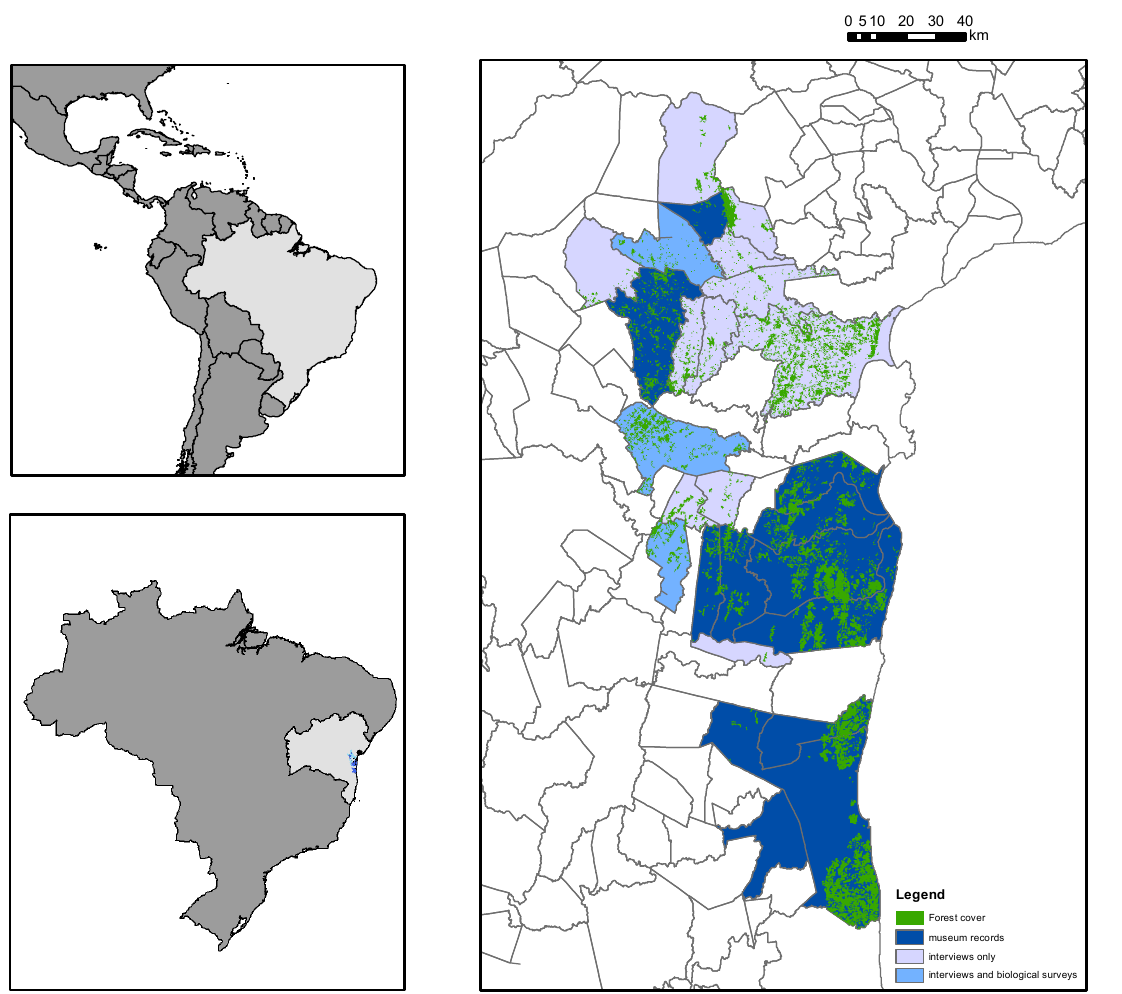
Figure 2. Atlantic forest fragments in the municipalities where Bothrops pirajai has been found to be present by biological and social